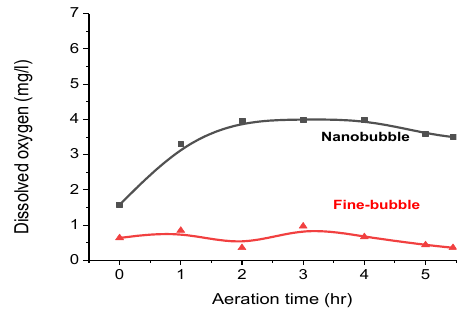
Fig. 2. Changes in Dissolved Oxygen in Reactor Mixed Liquor (SRT=20 d, COD=600 mg/l)